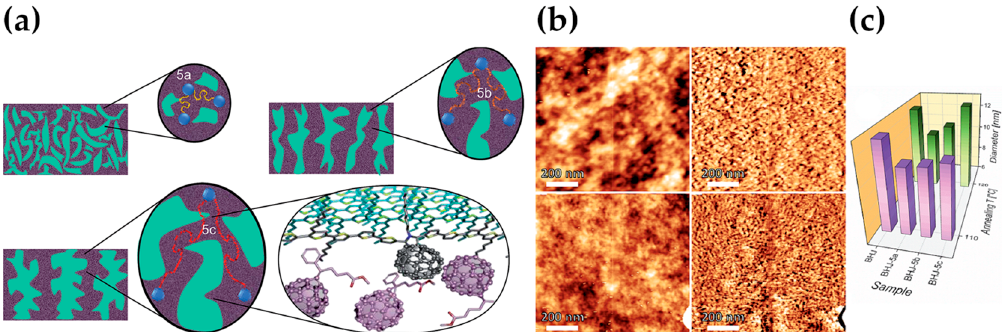
Figure 8. CBs based on fulleropyrrolidine copolymers bearing oligothiophene substituents at differ- ent length. ( a ) Domain size distribution regulated by the copolymers 5a–c. ( b ) The AFM characteriza- tion (morphology and phase) of the deposited films without (at the top) and in presence (at the bot- tom) of the 5b copolymer (2 wt.%). ( c ) Investigation on the P3HT domain size for BHJ, without copol- ymer and in presence of different copolymers (5a, 5b, and 5c). Thin-film characterization ( b , c ) was carried out after annealing at 110 °C for 5 min. Reproduced from Reference [151], with permission from the Royal Society of Chemistry.